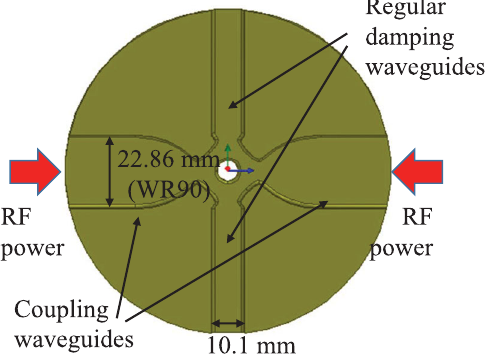
FIG. 13. Geometry of compact coupler cell.